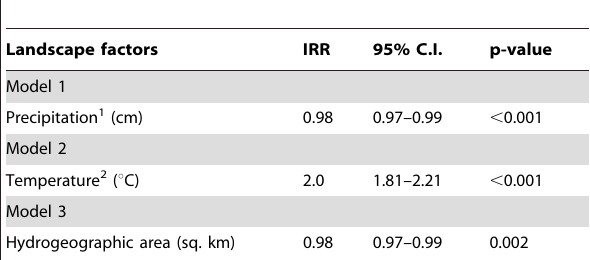
Table 1. Unadjusted incidence rate ratios (IRR) for the crude bivariate associations between human WNV and the landscape variables.